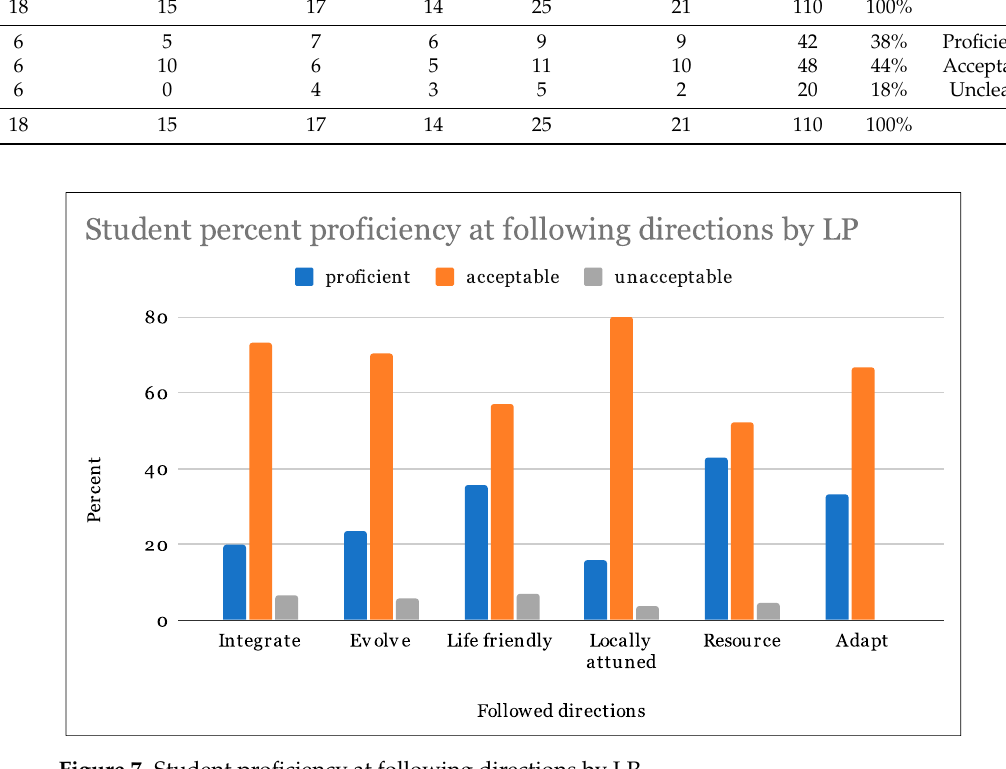
Figure 7. Student proficiency at following directions by LP.